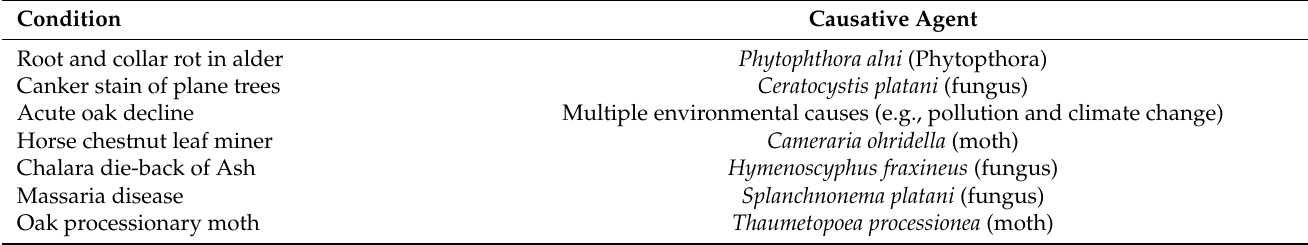
Table 3. Emerging tree diseases, some of which are affecting riparian vegetation in the UK. Condition Root and collar rot in